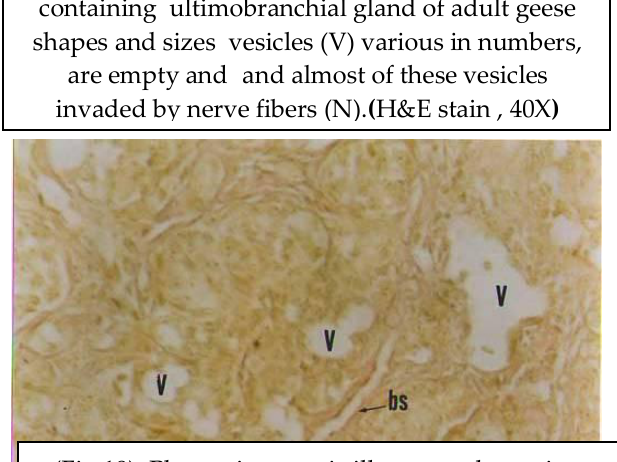
(Fig.19): Photomicroscopic illustrates the various size of vesicles (V) in the ultimobranchial gland of young geese distributed among the stroma of gland and these vesicles are invaded by blood